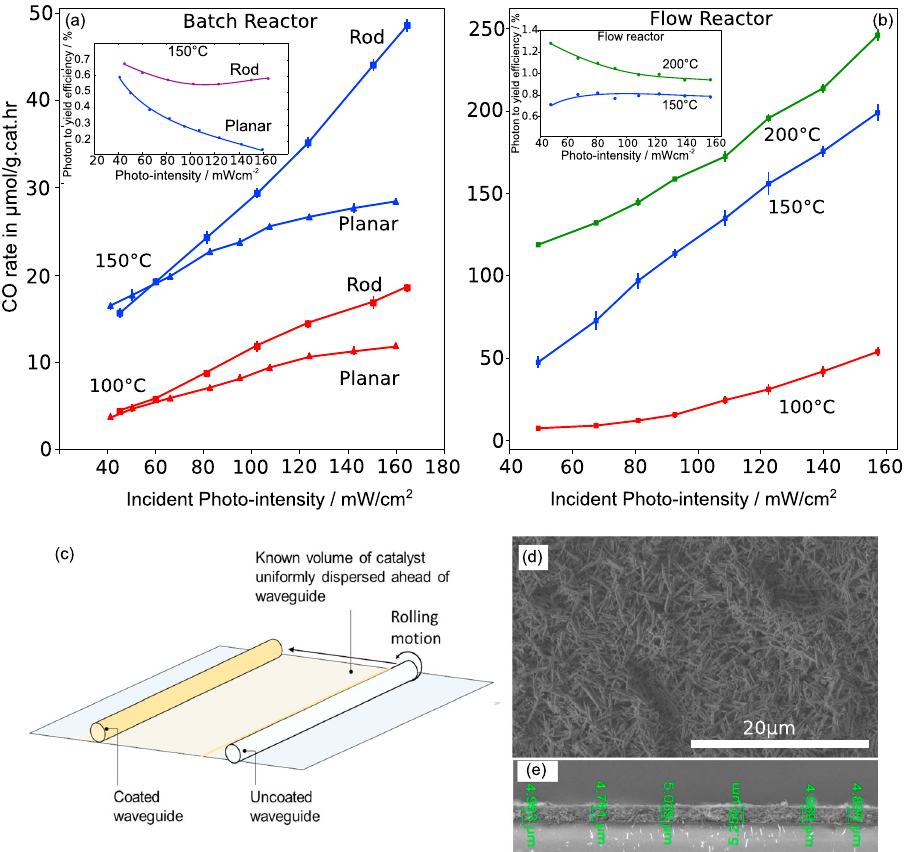
Fig. 1 Batch and fl ow reactor results. a , b The CO production rates and associated activation energies and photon to yield quantum ef fi ciencies for the batch reactor and fl ow reactor con fi gurations, respectively. (a) Shows the CO rates for the coated cylindrical rod waveguide and coated planar substrate at 100 and 150 °C. The coated planar CO rates at 150 °C showed semi-saturation trends at increasing photo-intensities, while the coated rod showed a linear increase. Insets of ( a ) shows the photon to yield ef fi ciencies of the coated planar and rod geometries at 150 °C batch reactor temperature with increasing photo-intensities, indicating that the coated rod waveguide has a more consistent ef fi ciency of 0.8 – 0.9%. b The CO rates for the coated rod waveguide at 100, 150, and 200 °C fl ow reactor temperatures. Inset to ( b ) shows that the coated waveguide rods in the fl ow reactor have consistent photon to yield ef fi ciencies with increasing photo-intensities. c Coating procedure of the quartz rod using a thin fi lm colloidal solution of In 2 O 3 − x (OH) y nanorods. d , e The SEM topographic and cross-sectional view of the nanorod